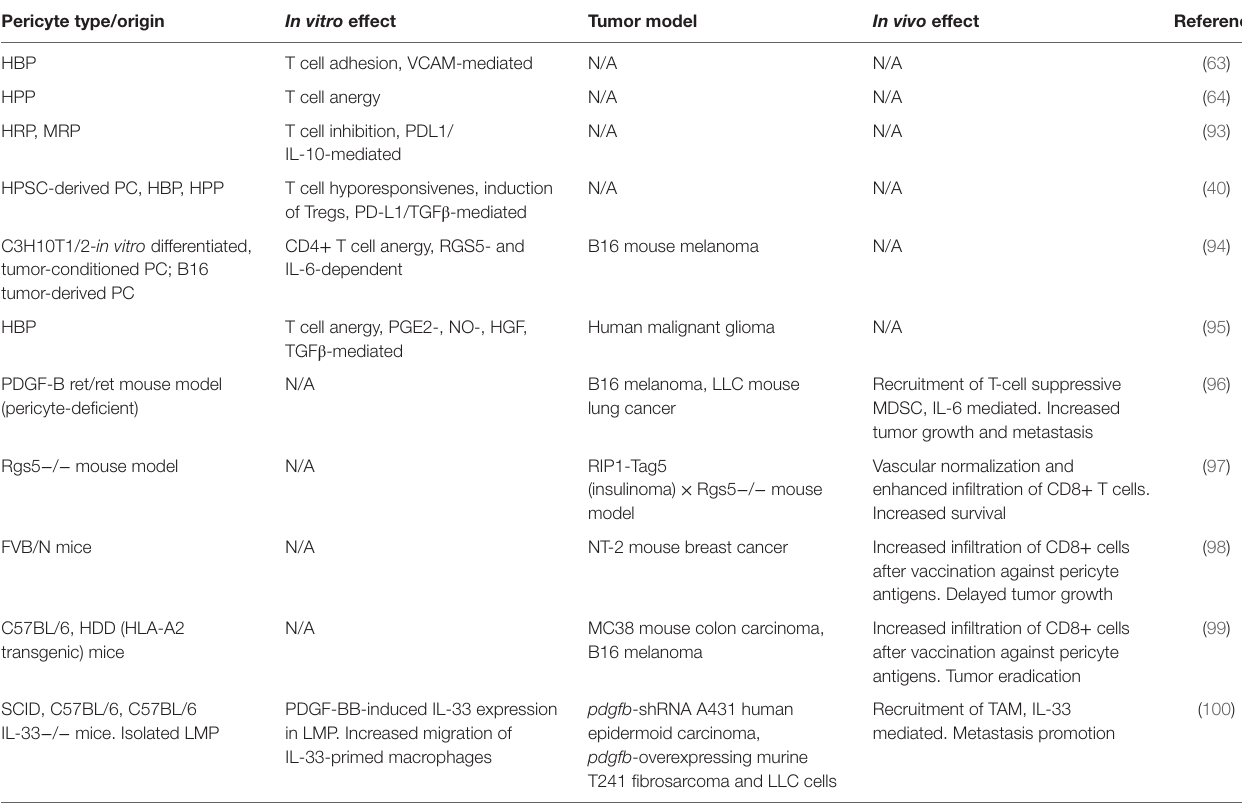
TAbLe 2 | Modulation of T cell activation and antitumoral immune response by